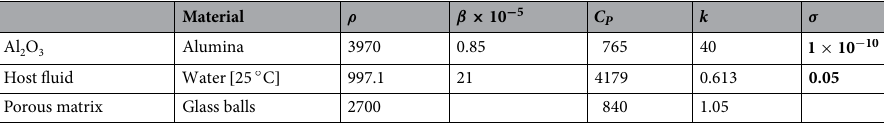
Table 1. Values of the thermophysical properties, see Corcione et al. 52 . Significant values are in